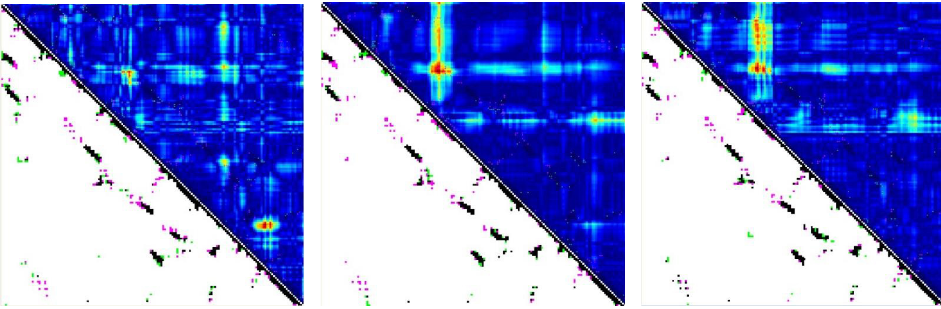
Figure 8: (Left) The contact map of Flavodoxin in B (left-lower triangle) and different contact map of Flavodoxin in B and Flavodoxin in A (right-upper triangle). (Center) The contact map of Flavodoxin in C (left-lower triangle) and different contact map of Flavodoxin in C and Flavodoxin in A (right-upper triangle). (Right) The contact map of Flavodoxin in D (left-lower triangle) and different contact map of Flavodoxin in D and Flavodoxin in A (right-upper triangle). The colors used in the figure are described in the main text.